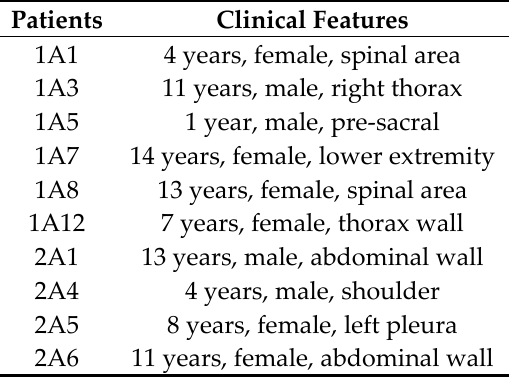
Table 1. Clinical features of each